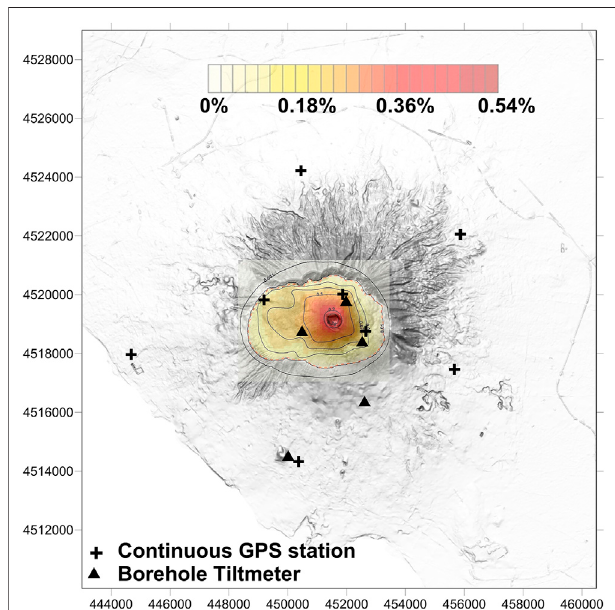
FIGURE 8 | Comparison of the present continuous geodetic network (GPS and tiltmeters) with the long-term probability of new vent opening inside the caldera for Plinian and sub-Plinian eruptions for Vesuvio (redrawn from Tadini et al., 2017).